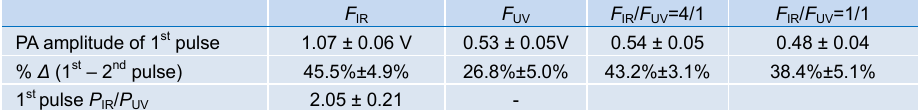
Table 2 | 1 st pulse PA amplitude values for various irradiation